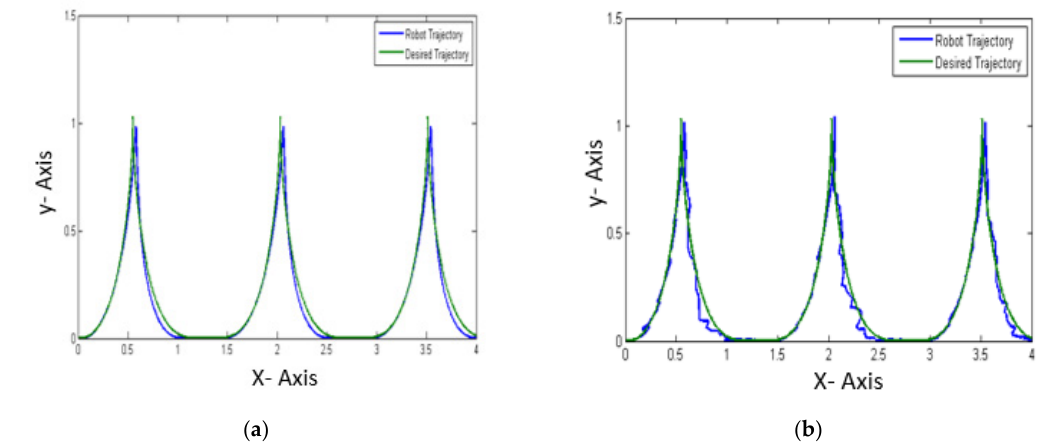
Figure 11. Best simulation OFDE ( a ) without noise and ( b ) with noise.